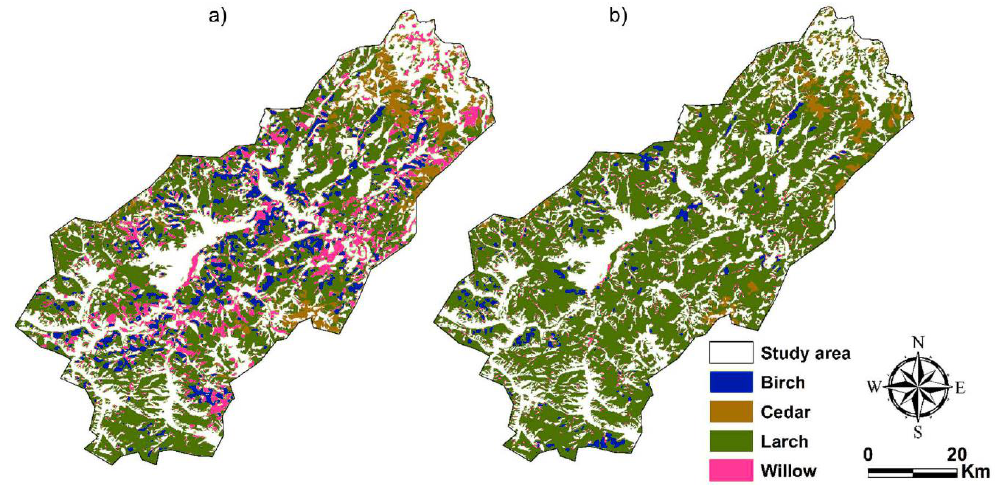
Figure 6. Forest tree species classification map ( a ) L8SR only and ( b ) L8SR coupled with topographic variables. The area in white masks out the area where brushwood, shrubs, burned forest, bare soil, and water is